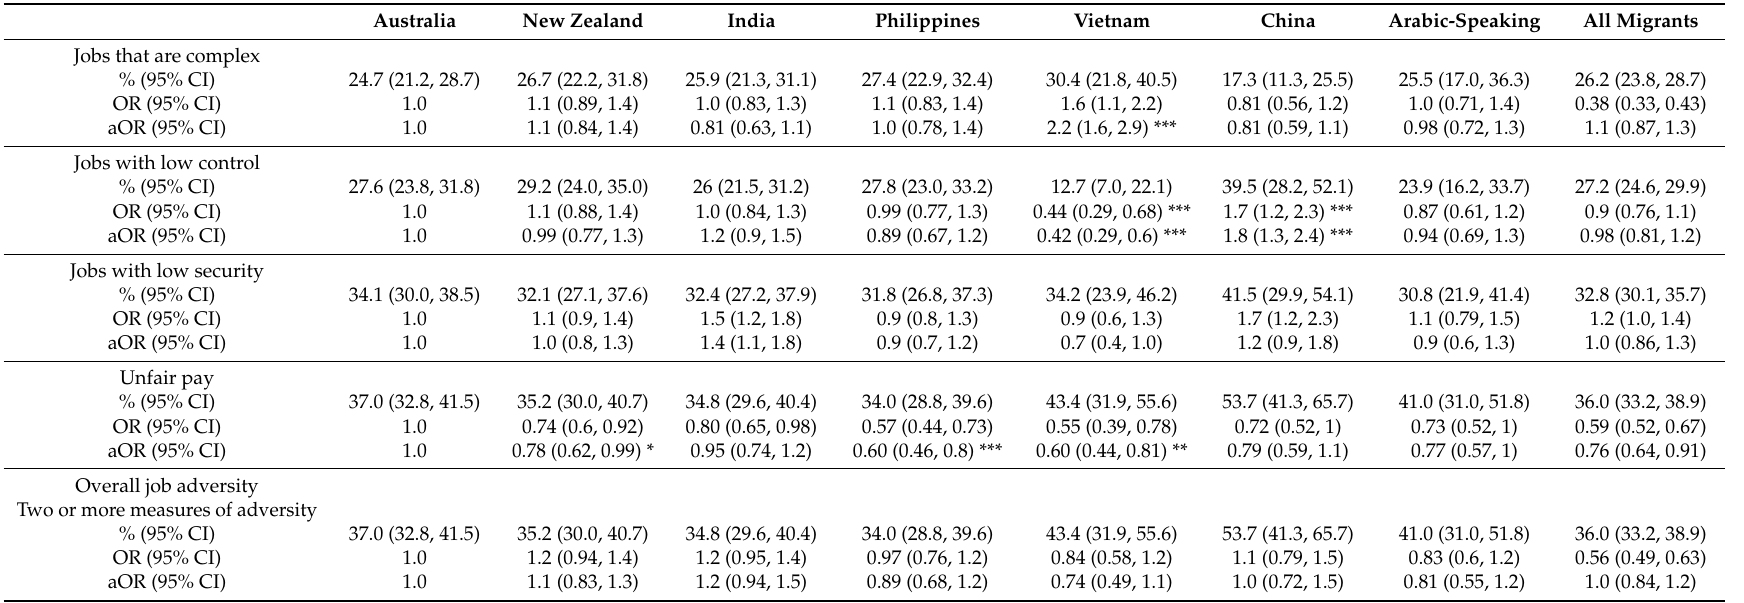
Table 2. Prevalence of psychosocial job quality factors with unadjusted and adjusted odds ratios (aORs) by country of birth, for the Australian Worker, Migrant Worker I, and Migrant Worker II surveys. Australia New Zealand India Philippines Vietnam China Arabic-Speaking All Migrants Jobs that are complex % (95% CI)